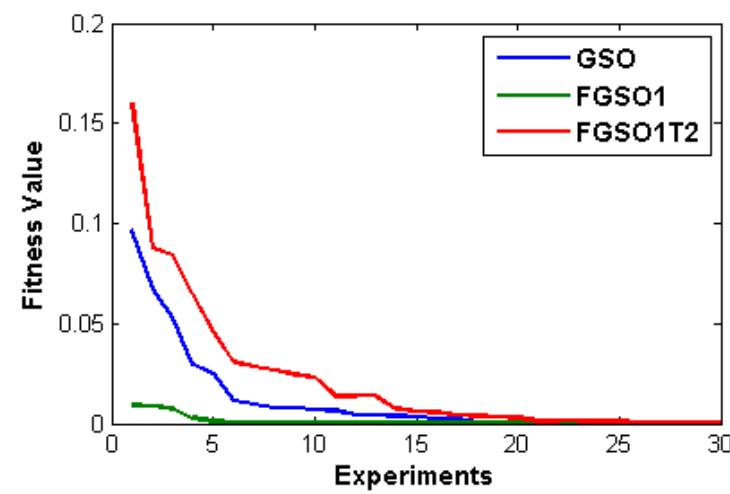
Figure 13. Results for GSO, FGSO1 and FGSO1T2 without noise. Table 3. Results with noise for GSO.